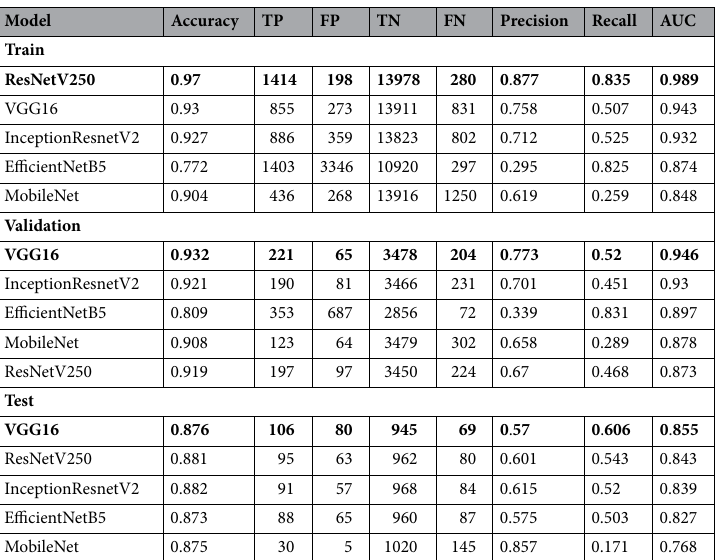
Figure 2. Examples of training curves and confusion matrix for the best overall performing model (VGG16). ( a ) Loss function value for training and validation data. ( b ) AUC value for training and validation data. In ( a ) and ( b ) the hatched area indicates the epochs after which the model started to overfit, the thick colored lines show smoothed loss or AUC values (average at every 10 epochs), and the transparent lines show raw loss or AUC values. ( c ) confusion matrix calculated using test data only.